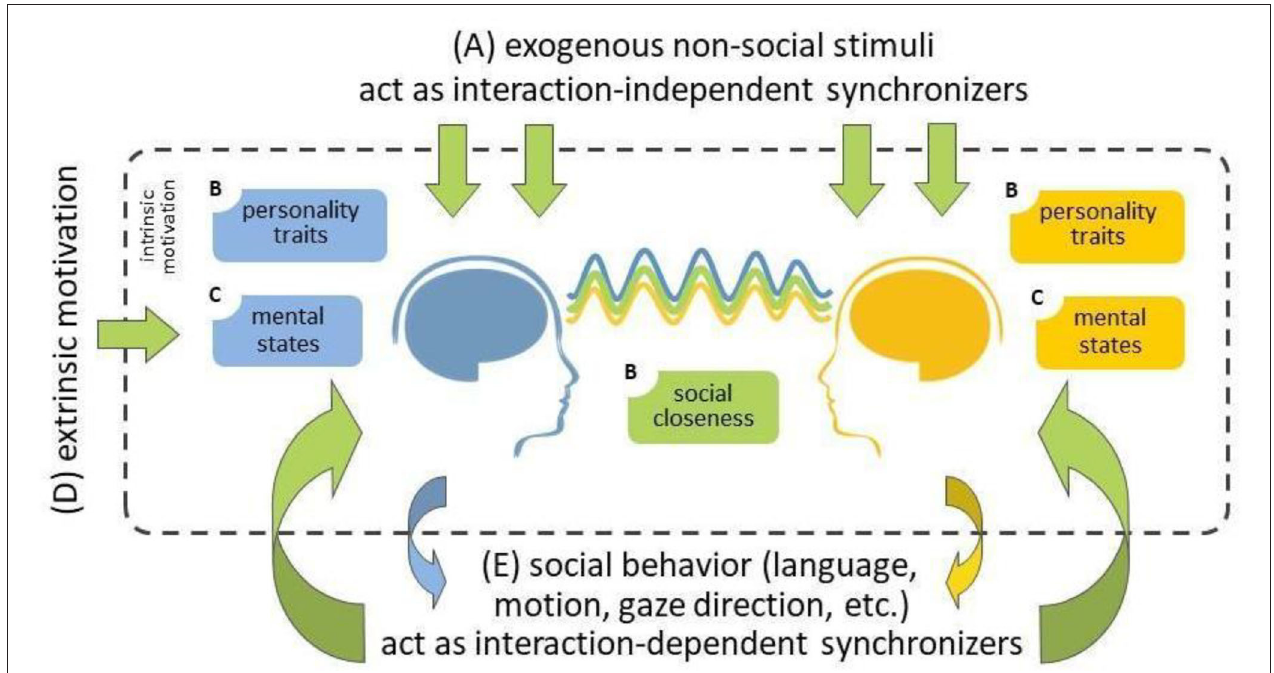
FIGURE 1 | A summary of possible sources of inter-brain synchrony during social interaction (adapted from Dikker et al., 2021). (A) External non-social stimuli (top) and (E) social behavior (bottom) provide exogenous sources of shared stimulus entrainment and interpersonal social coordination, respectively, leading to similar brain responses, i.e., inter-brain synchrony. (B) Both individuals’ social closeness and personality traits (e.g., affective empathy) affect their social engagement during the interaction, and thus the extent to which their brain responses become synchronized. (C) participants’ mental states (e.g., focus) similarly affect participants’ engagement with each other, intrinsically (endogenously) motivate participants to make an effort to connect to each other. (D) Such engagement can be “boosted” via extrinsic motivation, which could subsequently lead to increased inter-brain